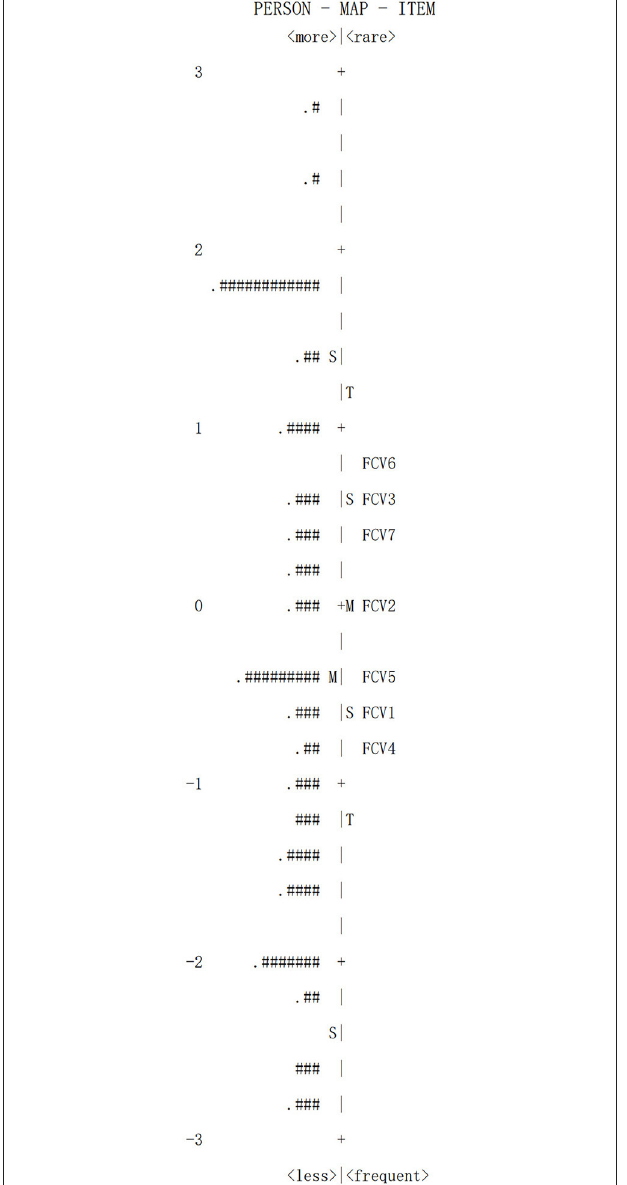
FIGURE 1 | Person-item map for the FCV-19S.